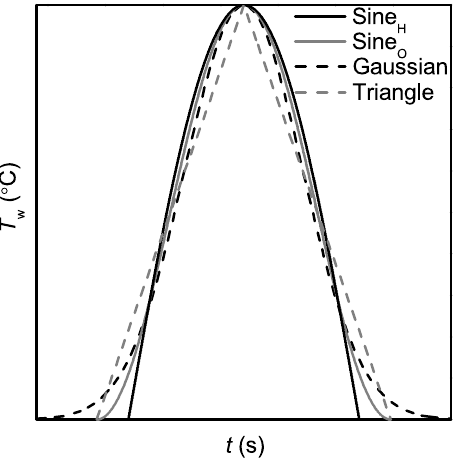
Figure 5. Different modeled recharge shapes. The sine H curve is widest near the peak and produces less damping and more retarda- tion than the other recharge shapes. Note that the ends of the Gaus- sian curve are not shown in this